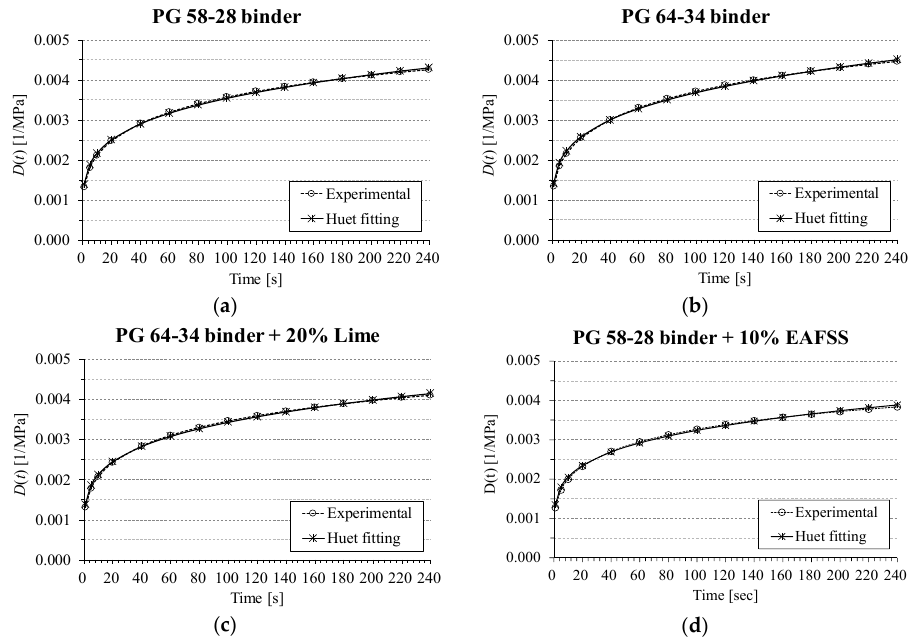
Figure 7. Huet model fitting of BBR binder and mortar (10 & 20%) D ( t ) = 1/ S ( t ). ( a ) PG 58-28 binder; ( b ) PG 64-34 binder; ( c ) PG 64-34 binder + 20% Lime; ( d ) PG 58-28 binder + 10% EAFSS.